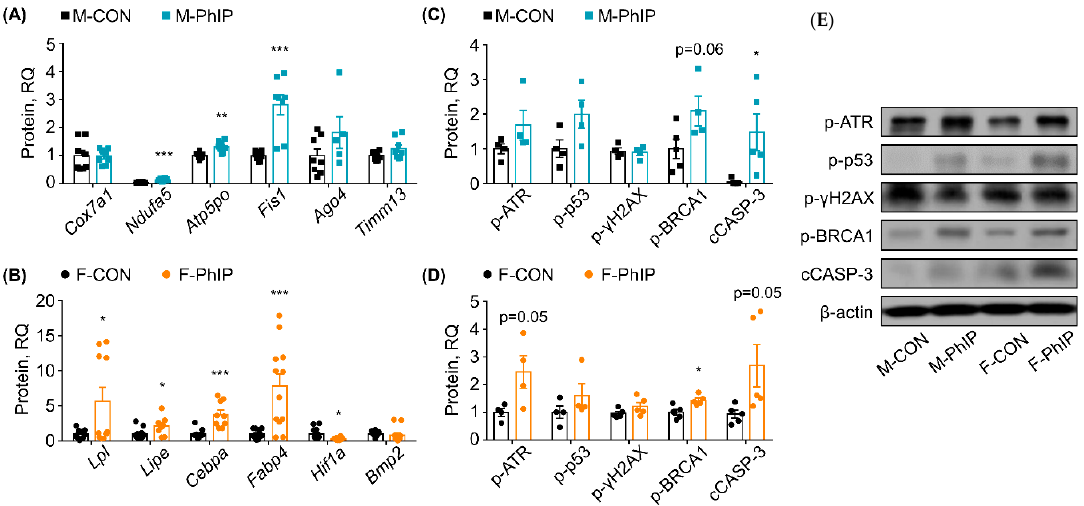
Figure 3. Validation of transcriptomics results using quantitative polymerase chain reaction (qPCR) analysis and assessment of protein expressions involved in DNA damage response (DDR) and apoptosis markers. ( A ) Genes were randomly selected from the top canonical pathways (i.e., Oxidative Phosphorylation, Mitochondria Dysfunction, eIF2 Signaling and Sirtuin Signaling Pathway) of the male colon transcriptome and assessed using qPCR analysis. ( B ) Genes were randomly selected from the top canonical pathways (i.e., Triacylglycerol Degradation, Retinol Biosynthesis and Adipogenesis Pathway) of the female colon transcriptome and assessed using qPCR analysis. Values are means ± SEM ( n = 5, n for repeated measures = 7–8). ( C , D ) Key proteins responsible for the DDR signaling pathway and apoptosis markers were measured using ( E ) Western blot analysis. Representative protein bands for DDR signaling pathway and apoptosis marker proteins were quantified. Values are means ± SEM ( n = 4–5). * p < 0.05, ** p < 0.01, *** p < 0.001 (examined by a two-tailed, Welch’s t -test using GraphPad Prism 3.0 software; GraphPad, San Diego, CA, USA). M-PhIP, male mice treated with PhIP; M-CON, control male mice; F-PhIP, female mice treated with PhIP; F-CON, control female mice.